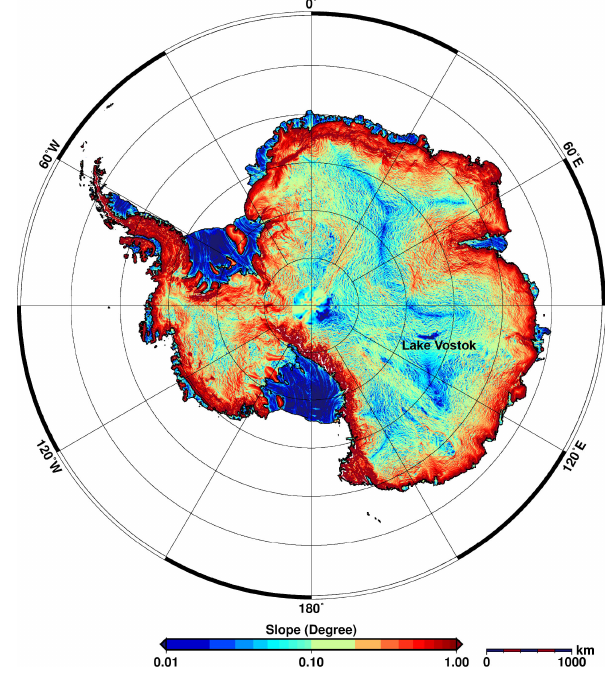
Figure 5. New elevation model of Antarctica derived from CryoSat-2.